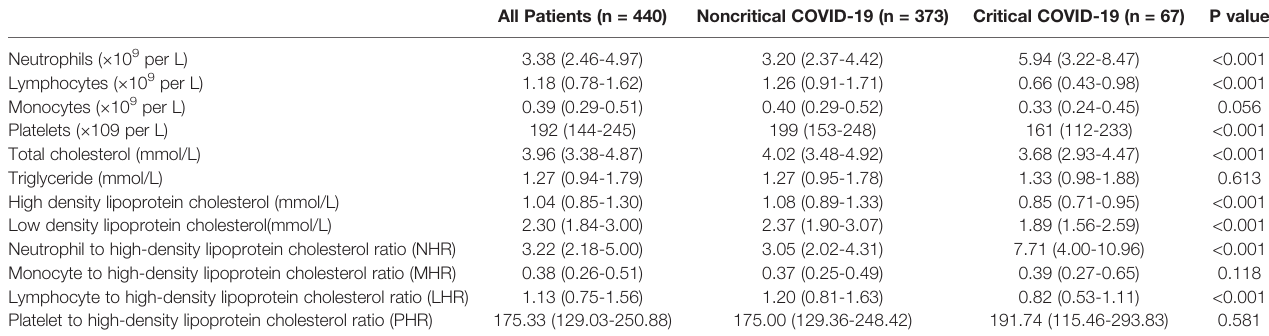
TABLE 2 | Laboratory fi ndings of patients with COVID-19 on admission to hospital.